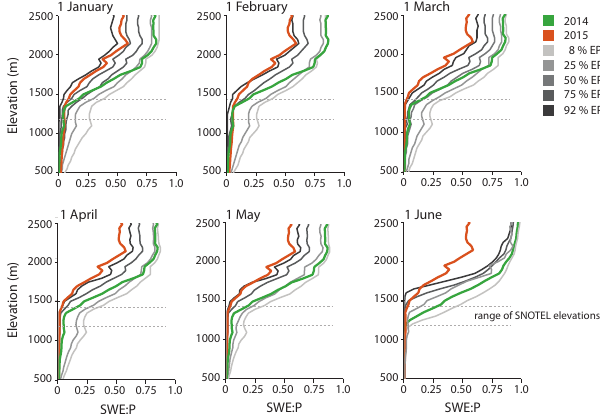
Figure 5. The spatial distribution of SWE on 1 April from water years 2014 and 2015 as compared to the corresponding EP. Both the distribution and magnitude of SWE are strikingly similar. The calculations are 5-day averages centered on the first day of each month.